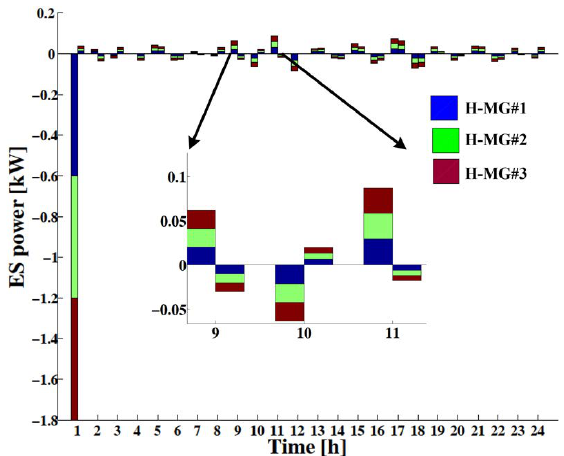
Figure 9. ES power of each H-MG in charging/discharging mode.